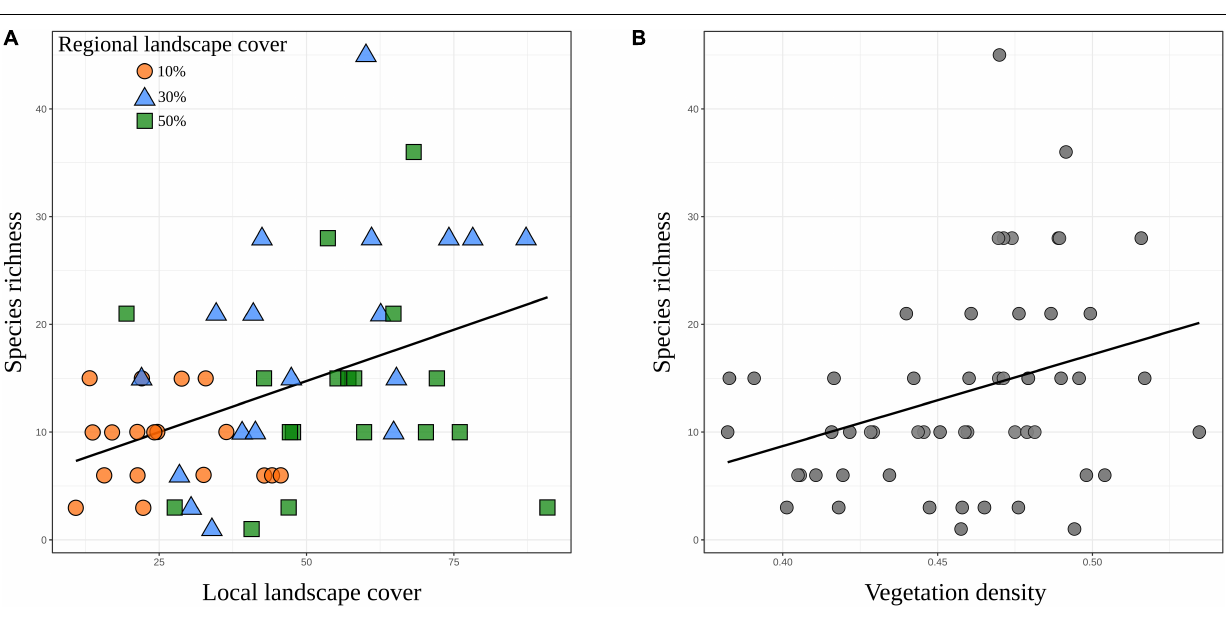
Frontiers in Ecology and Evolution |